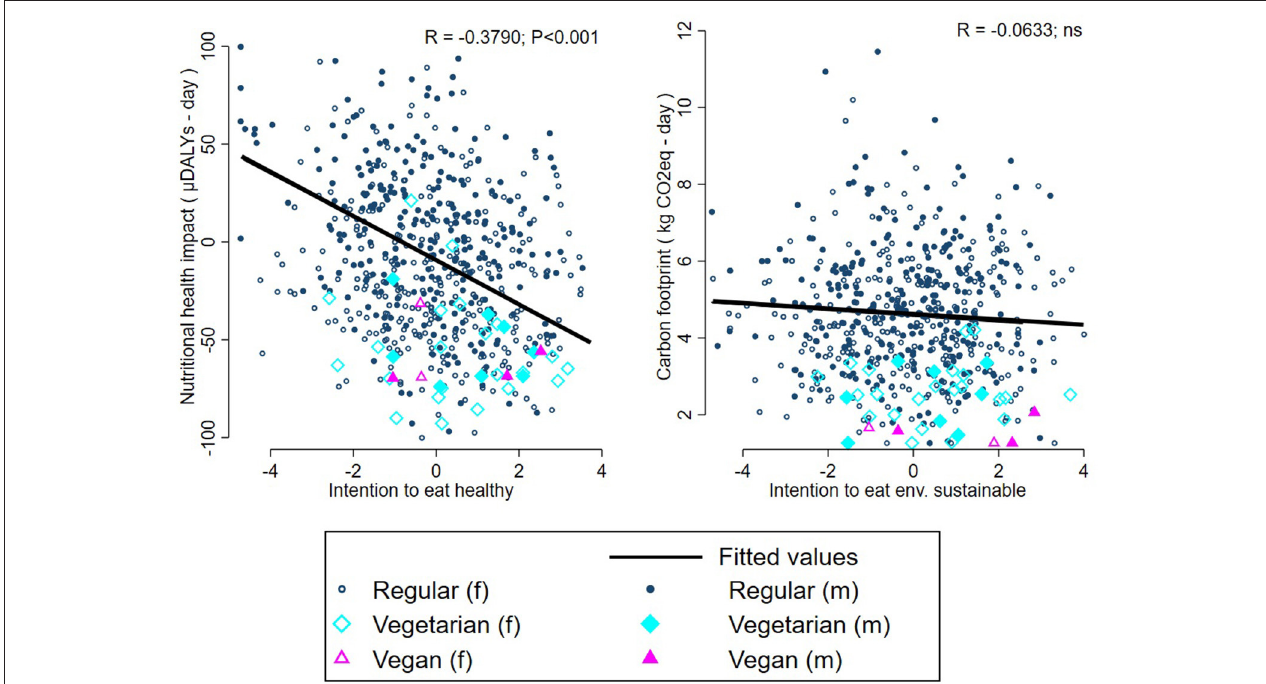
FIGURE 4 | Human health impacts and carbon footprint as a function of the intention to eat healthy and environmentally sustainable eating. Relevant contributions of intentions toward healthier eating. No contributions of the intention for the case of environmentally sustainable eating.